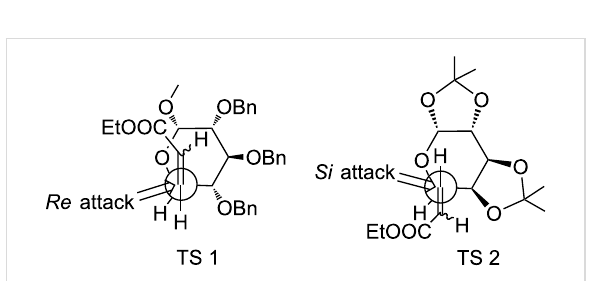
Figure 4: Preferential re -attack according to the Felkin–Anh model (TS 1) yielding 10b (left) and si -attack (TS 2) providing 10c (right).